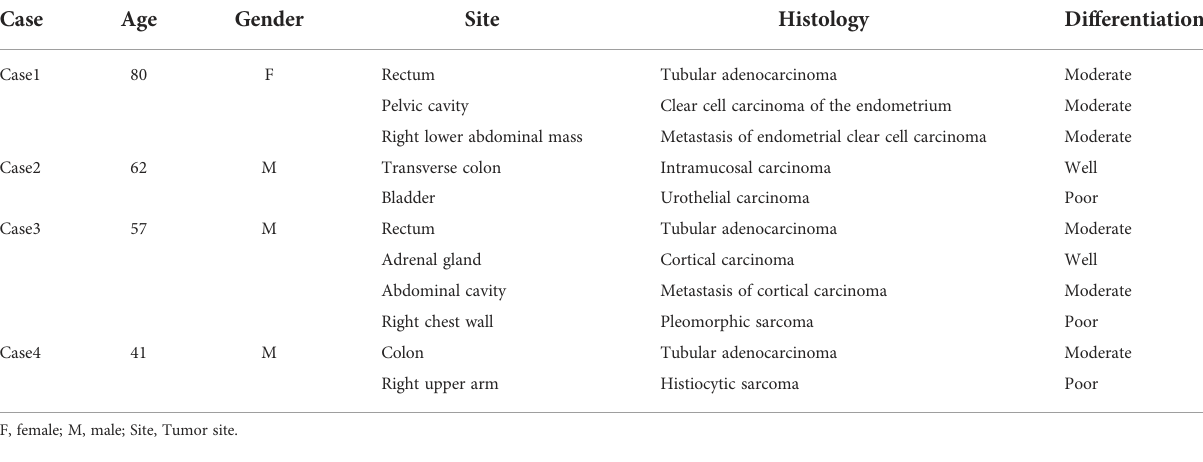
TABLE 1 Clinicopathological